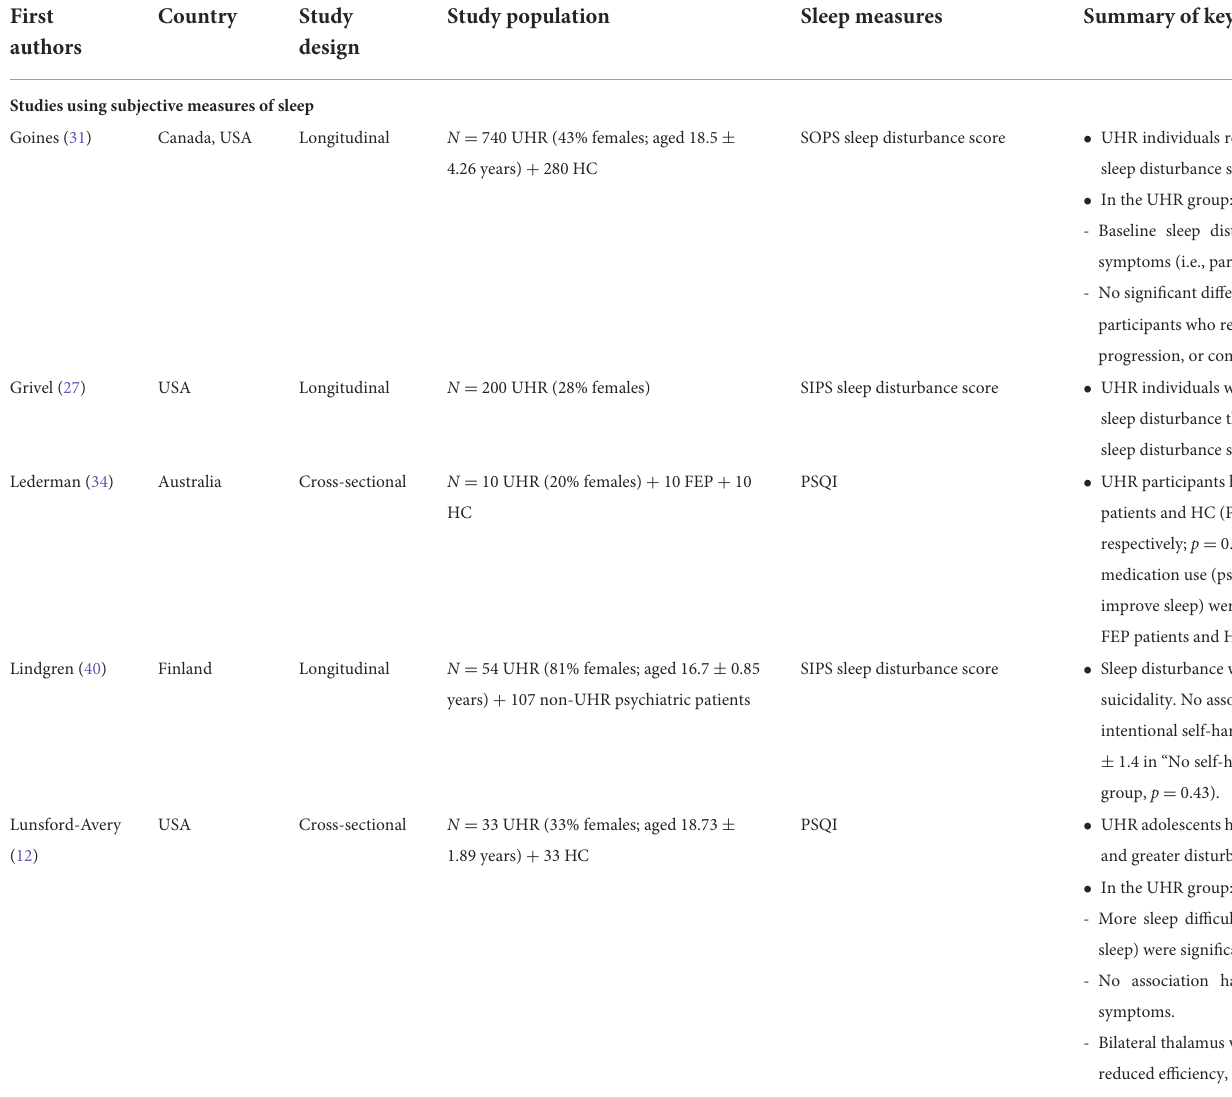
TABLE 1 Summary of the previous research findings on sleep disturbances in UHR individuals *